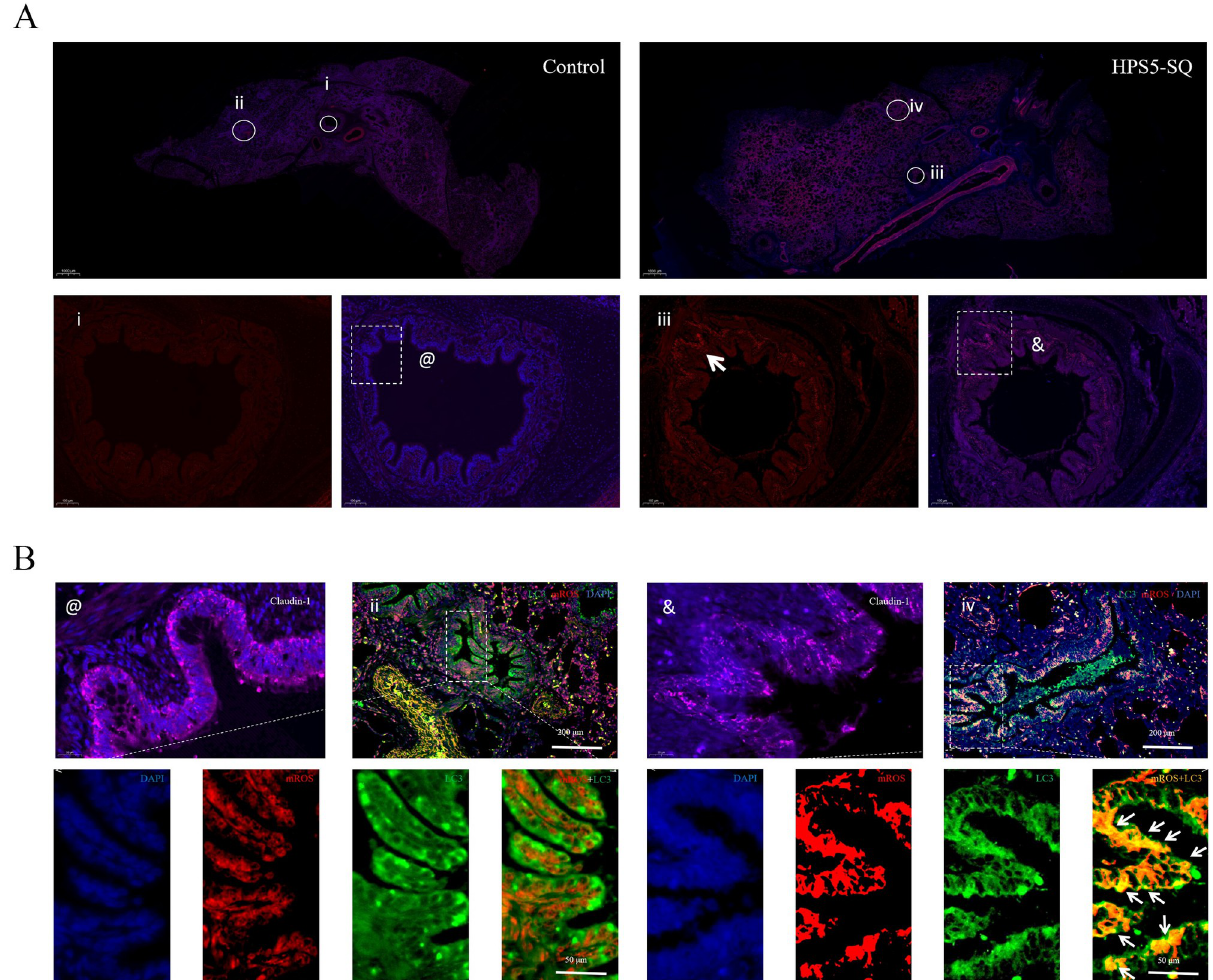
Fig 6. HPS5-SQ-mediated autophagy involves the decline of porcine respiratory epithelial Claudin-1. (A) The mROS staining of piglets’ lung tissue section of the autopsy showed the mROS (red) and the nucleus (blue). Scale bars: 1000 μ m, 100 μ m. (B) Pictures were marked by @ and & in Fig 6A, and immunofluorescence microscopy detected the Claudin-1 (pink) and DAPI (blue) in piglets lung tissue. The picture was marked by ii and iv in Fig 6A, and immunofluorescence microscopy detected the localization of mROS(red), LC3(green), and DAPI (blue) in healthy piglets lung tissue infected with HPS5-SQ. Scale bars: 200 μ m, 50 μ m, 20 μ